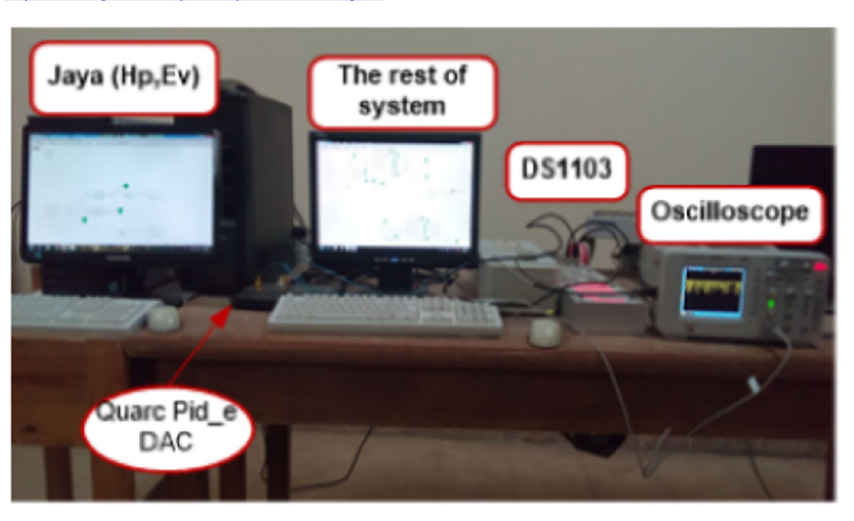
Fig 13. Real-time laboratory setup.